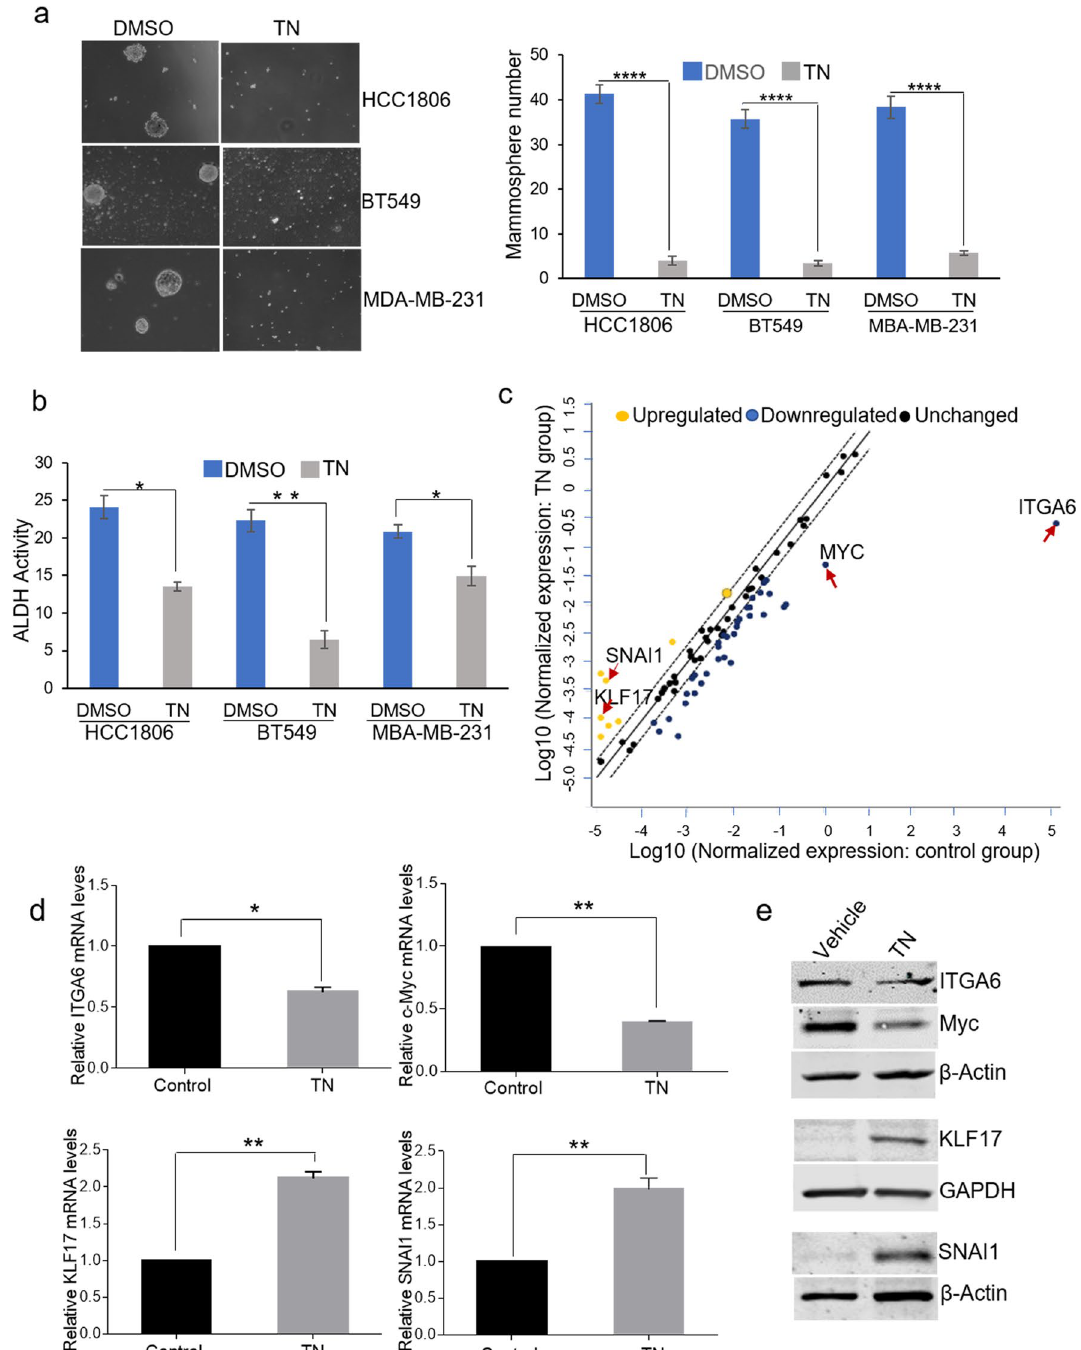
Figure 2. Triptonide attenuates stem-like properties of TNBC cells. ( a ) Mammosphere formation assay in HCC1806, BT549, and MDA-MB-231 TNBC cells treated by triptonide for 96 h. Each bar is presented as mean ± SD (n = 3). ( b ) ALDH activity assays of HCC1806, BT549, and MDA-MB-231 cells treated by triptonide or vehicle for 20 h. Each bar is presented as mean ± SD (n = 3) (**, p < 0.01). ( c ) RT 2 profiler PCR array of HCC1806 cells treated with 0.2 µM triptonide for 10 h using the ΔΔCT method of quantification with RT2 Profiler PCR Arrays kit. ( d ) Expression of ITGA6, Myc, KLF17, and Snail by RT-qPCR. Each bar is presented as mean ± SD (n = 3) (*, p < 0.05. **, p < 0.01). ( e ) Immunoblotting of ITGA6, MYC, KLF17, and SNAI1 in HCC1806